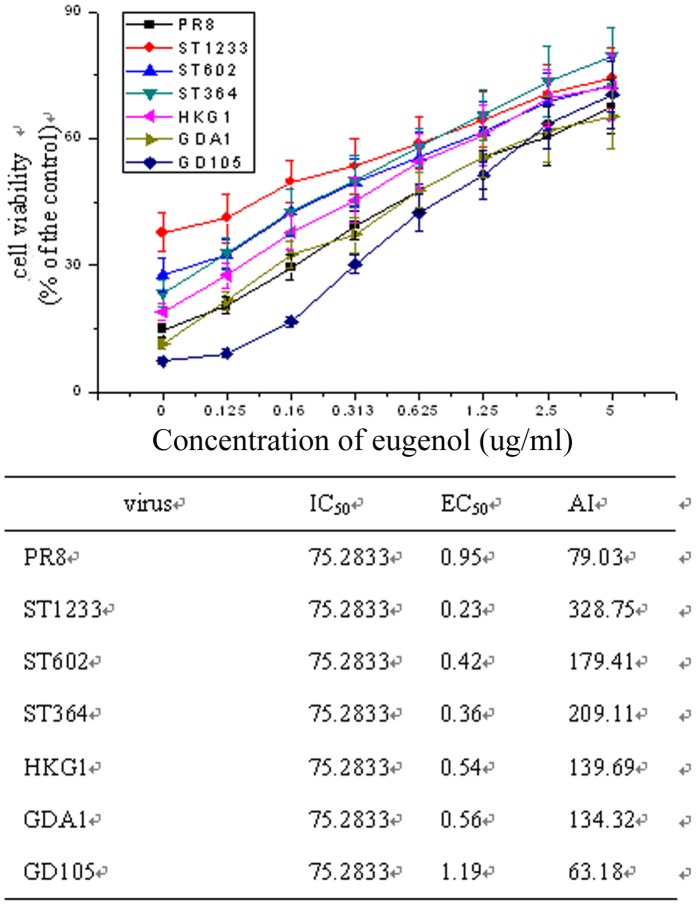
Antiviral activity of eugenol on A/PuertoRico/8/34 (H1N1, PR8), A/ShanTou/1233/06 (H1N1, ST1233), A/ShanTou/602/06 (H3N2, ST602), A/ShanTou/364/05 (H3N2, ST364), A/Quail/HongKong/G1/97 (H9N2, HKG1), A/Chicken/Guangdong/A1/03 (H9N2, GDA1) and A/Chicken/Guangdong/1/05 (H5N1, GD105) determined by the SRB method using CPE reduction.OD value was read at 562 nm. 0.5% DMSO was used in each group. Percent protection of test compounds (cell viability) was calculated according to the formula shown in Materials and methods. Concentration of 50% protection was defined as EC50. The antiviral index (AI) was defined as IC50/EC50. Data shown were the mean ± SD of three independent experiments.